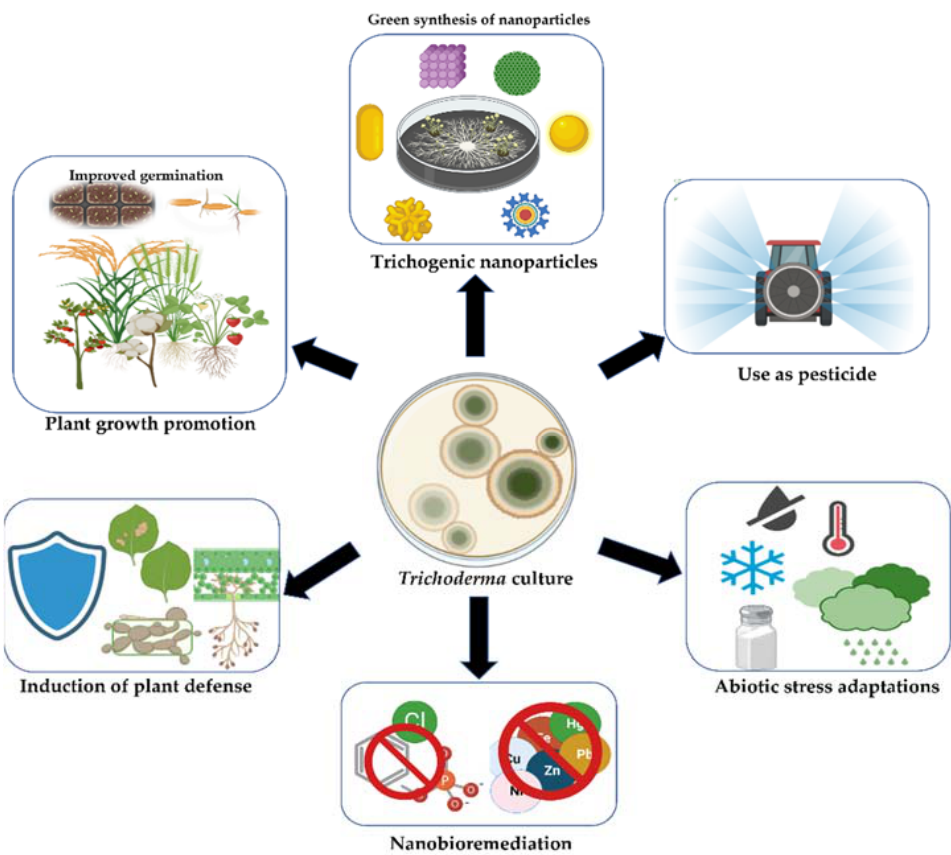
Figure 2. Trichoderma applications in the agricultural ecosystem. Red circle indicates stopping of the heavy metal contamination through active removal by nanomaterials. This figure was created with BioRender software.